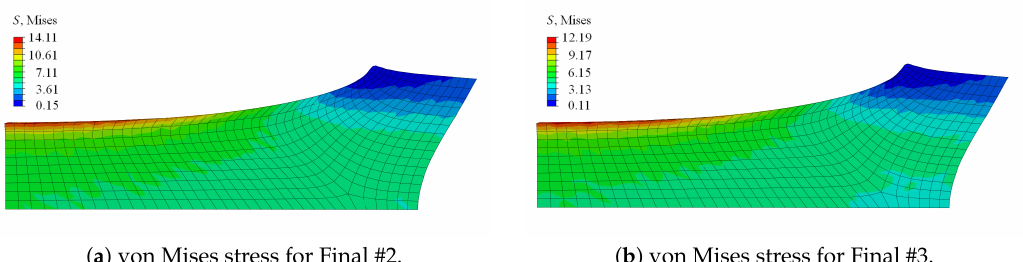
Figure 10. Comparison of the contour plot of the von Mises stress at the final load step for ( a ) the optimised Parameter Set #2 with n iso = 0.9 and ( b ) the optimised Parameter Set #3 with n iso =